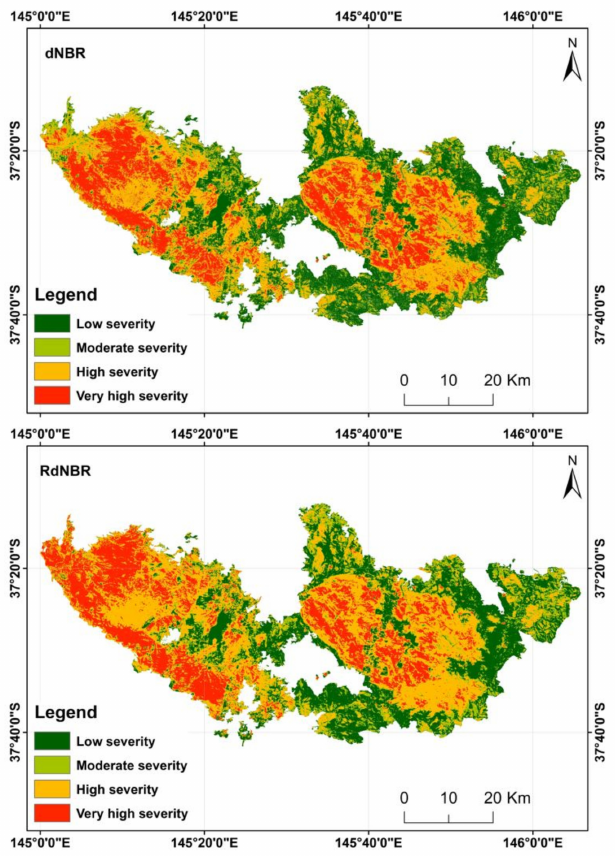
Figure 5. Bushfire severity maps of Kilmore-east–Murrindindi region Victoria. The burn severity is calculated by using dNBR and RdNBR index. The severity classes are categorised into very high, high, moderate, and low severity classes as per the classification threshold presented in Table